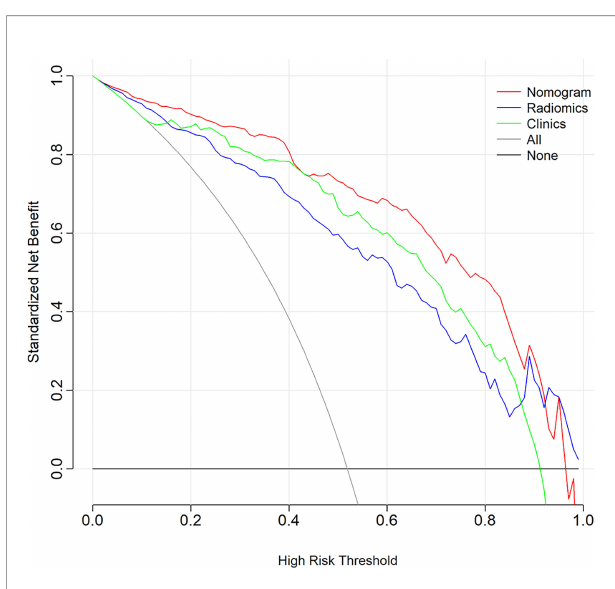
FIGURE 7 | Decision curve analysis for the radiomics